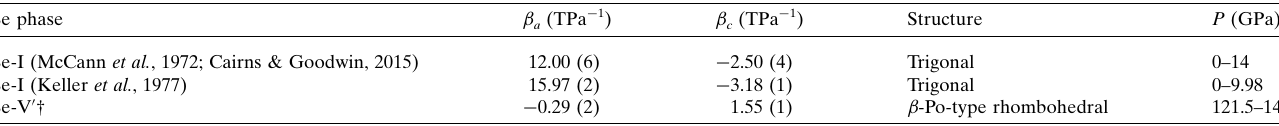
Table 2 Linear compressibilities of selenium. Compressibilities of Se-I summarized from previous reported works and Se-V 0 from this work. Se